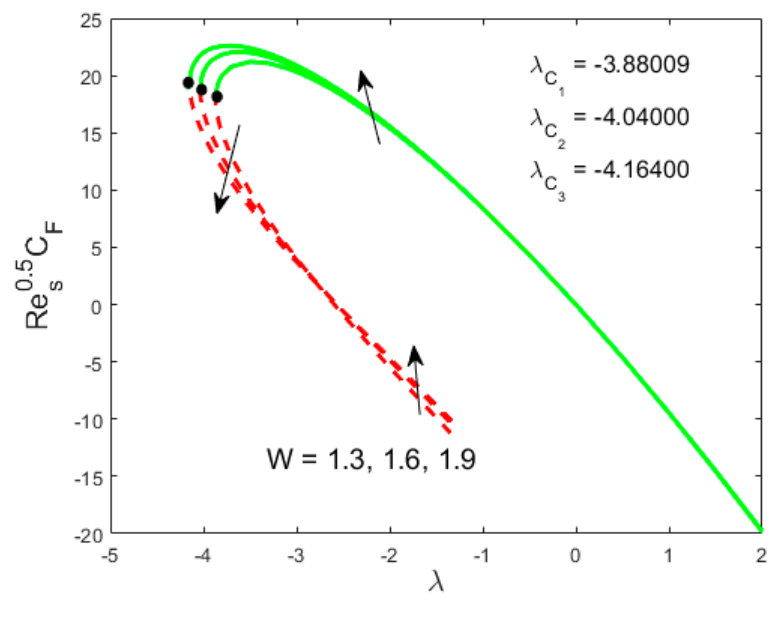
Figure 18. Influence of W on Re 0.5 s C F versus λ .